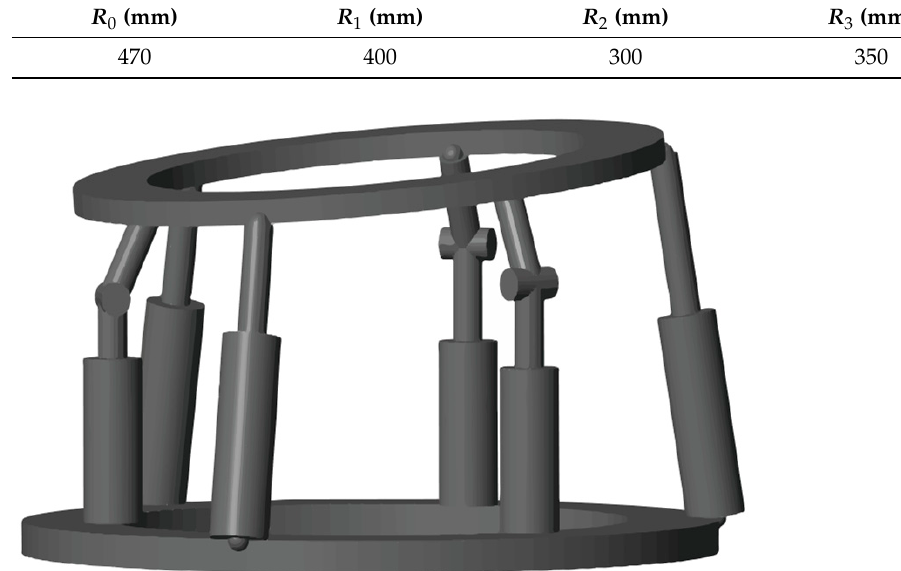
Table 1. The dimension parameters of the PM.